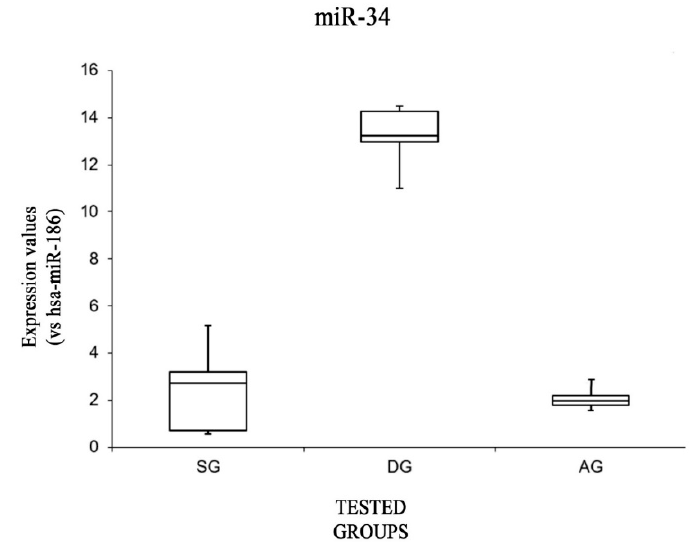
Figure 4. Box plot analysis showing the expression levels of miRNA 34 (endogenous control miR-186) in each group.